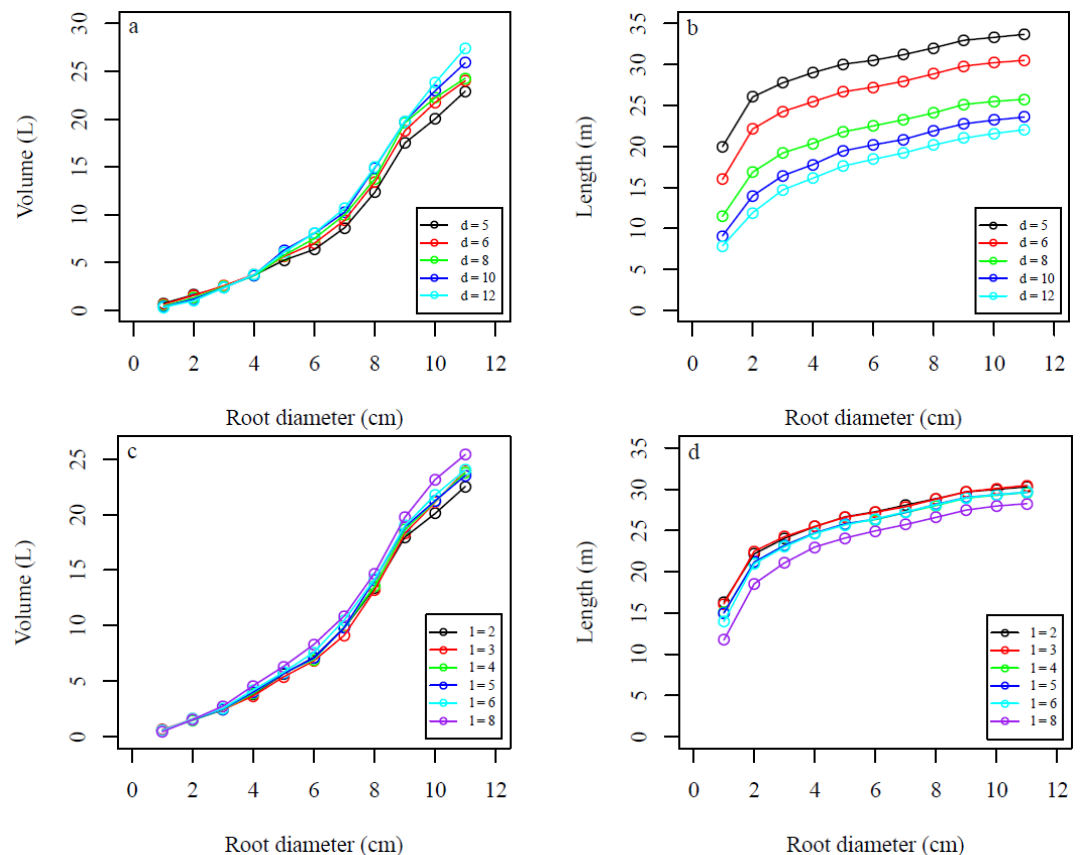
Figure 12. Average sensitivity of QSMs for different values of the d (the minimum distance between the centers of the balls and the maximum distance between any point and its nearest center) and l (relative cylinder length) parameters and root diameters for 15 model fits of stump 2. ( a , c ) Root volume and ( b , d ) linear root length for different ( a , b ) d values and ( c , d ) l